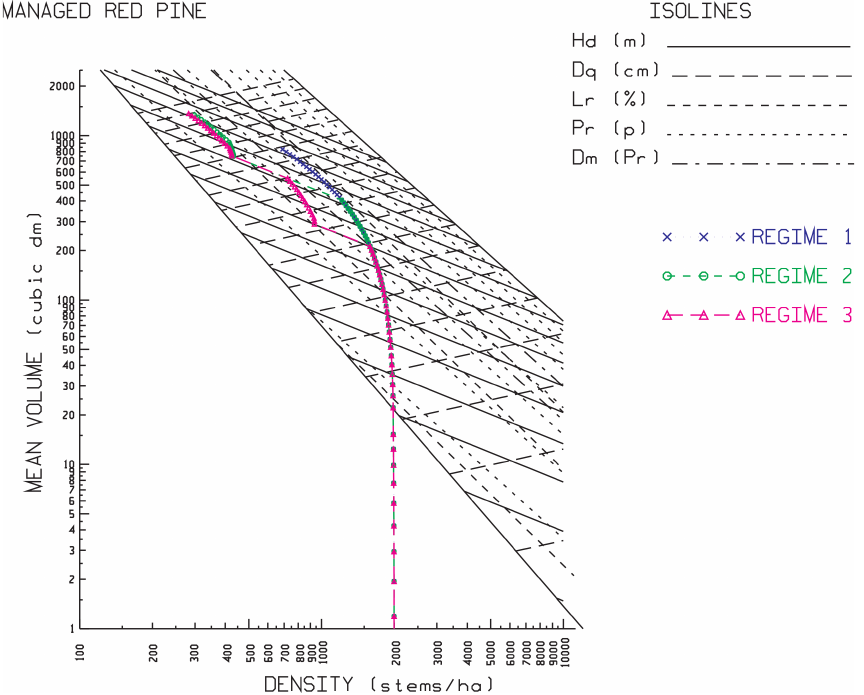
Figure 2. Temporal size–density trajectories for the three red pine plantations growing under condi- tions consistent with observed 1971–2000 climate norms (Table 1) on a medium-to-good site quality (SI = 23) situated in north-central Ontario (Thessalon) as illustrated within the context of the SDMD graphic. Specifically, graphically illustrating: (1) isolines for mean dominant height (Hd; 4–34 m by 2 m intervals), quadratic mean diameter (Dq; 4–40 cm by 2 cm intervals), mean live crown ratio (Lr; 35, 40 and 50%), relative density index (Pr; 0.1–1.0 by 0.1 intervals); (2) crown closure line (lower diagonal solid line) and self-thinning rule at a Pr = 1.0 (upper diagonal solid line); (3) lower and upper Pr values delineating the optimal density management window (Dm; 0.35 ≤ Pr ≤ 0.50); and (4) expected 75 year (2022–2097) size–density trajectories with one-year intervals denoted for each of the crop plans (i.e., Regime 1 representing an initial spacing (2.2 × 2.2 m) with a no-thinning crop plan, Regime 2 representing an initial spacing (2.2 × 2.2 m) with one commercial thinning (CT) treatment (35% basal area removed at 55 year) crop plan, and Regime 3 representing an initial spacing (2.2 × 2.2 m) with two CT treatments (20% basal area removed at 40 and 55 year) crop plan). Refer to Table 2 and textual description for additional crop plan